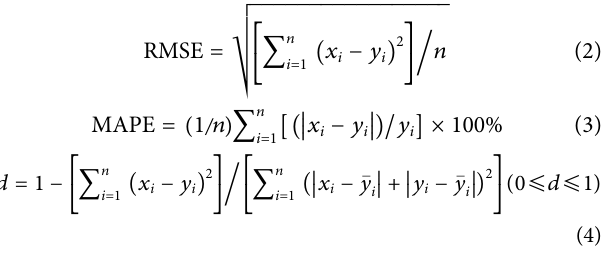
( Table 3 ). Humidity RMSEs are between 2.63% – 2.94% and less than 5% (Rosso et al., 2018). The